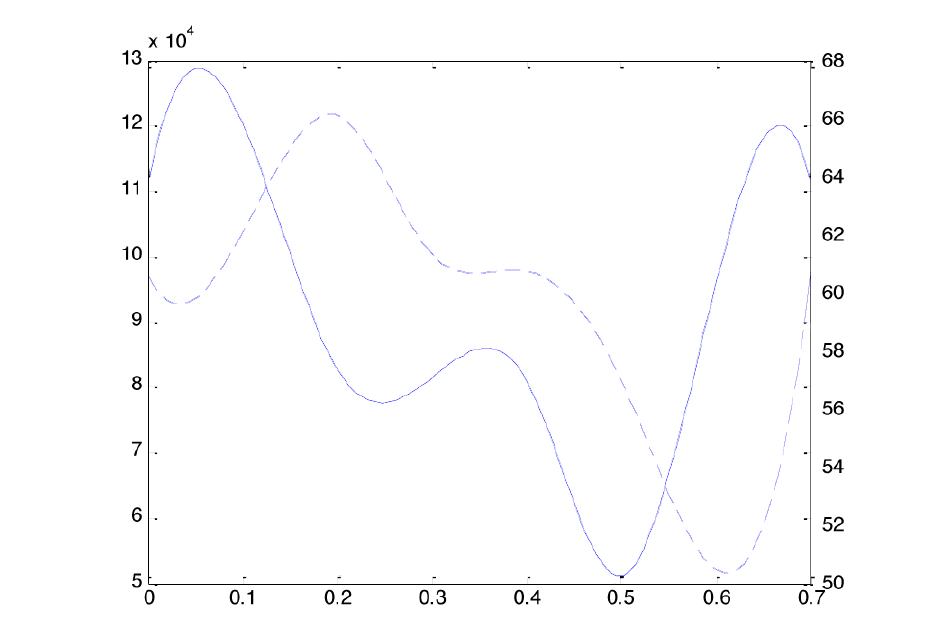
Figure 2. LVV varying cure (solid line) and LVLL varying cure (dash line) in whole cardiac